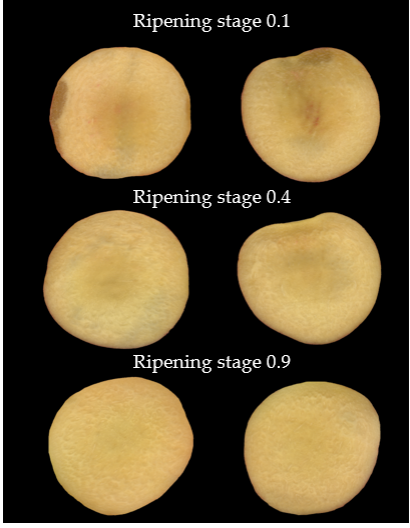
Figure 2. The flowchart of the classification of peaches with different ripening stages using image processing and machine learning.